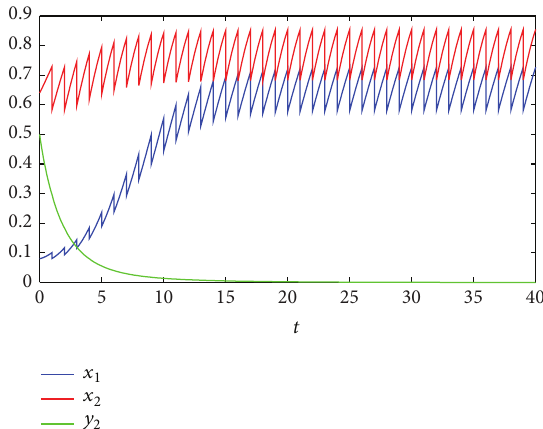
Figure 1: Dynamical behaviors of the predator-extinction solution of system (3) with initial value 𝑥 1 (0) = 0.1 , 𝑥 2 (0) = 0.8 , 𝑦 2 (0) = 0.5 and 𝑎 1 = 0.65 , 𝑎 2 = 1 , 𝑏 1 = 0.65 , 𝑏 2 = 1 , 𝑑 1 = 0.5 , 𝑑 2 = 0.7 , 𝛽 1 = 1 , = 1 , 𝜆 = 1 , 𝜆 = 1 , 𝑝 = 0.2 , 𝑝 = 0.2 , 𝑐 = 1 , 𝑐 = 0.8 , 𝑐 = 1 , 𝛽 2 1 2 1 2 1 2 3 = 1 , 𝑐 = 1 , 𝑟 = 0.25 , 𝜏 = 1 , and 𝑇 = 1 𝑐 4 5